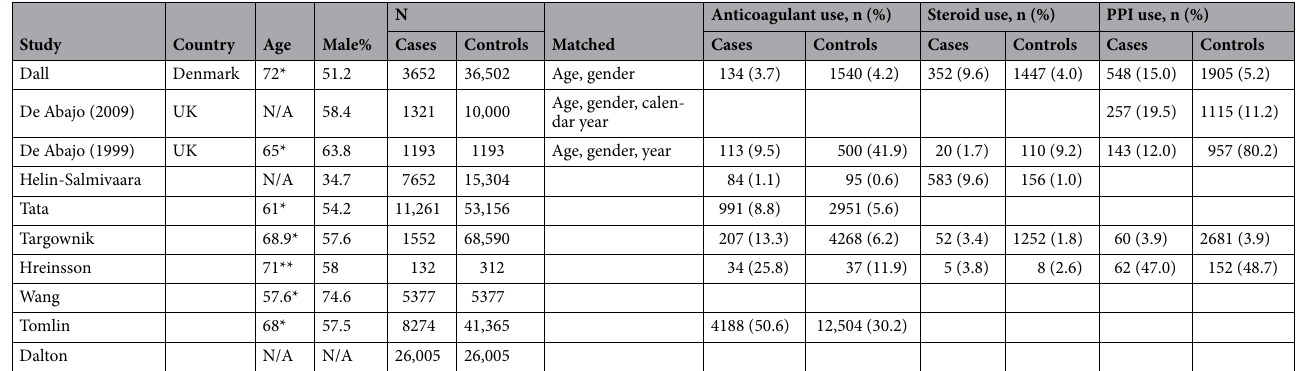
Table 1. Patient characteristics in included studies. PPI proton pump inhibitor. *Mean, **median, blank cells represent missing data